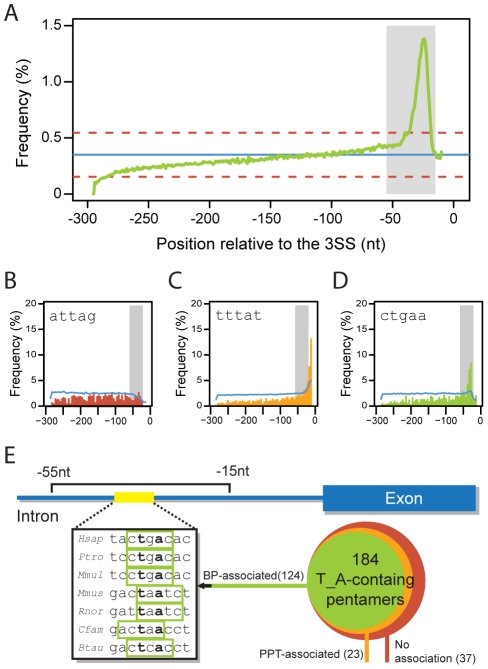
Building a set of conserved putative BPs.
A – Distribution of mammalian wide conserved TNA instances in the last 300nt of human introns. The blue line represents the mean frequency. The dashed red lines represent the mean+- the standard deviation. The grey area represents the region comprehended between 55 to 15 nt upstream the 3SS. B,C and D – Distribution over the last 300 nts in human introns for the mammalian-conserved instances of 3 example pentamers belonging to different categories: No association with any positionally biased signal (B), PPT-associated (C) and BP-associated (D). The line in blue represents the distribution of all (conserved and non-conserved) instances. The grey area represents the region comprehended between 55 to 15 nt upstream the 3SS. E – Scheme representing the employed strategy to build a set of conserved putative BPs. We selected TNA conserved instances located between 55 and 15 nts upstream the 3SS and unique to the last 300nt of the intron, if overlapped by at least one BP-associated pentamer in all species considered (see Methods).